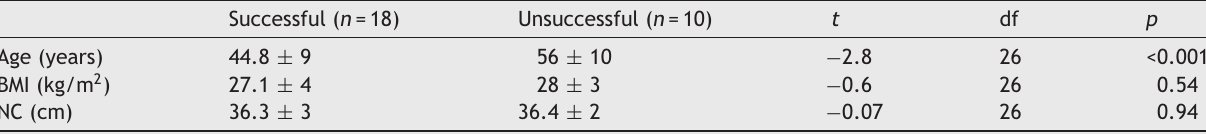
BMI, body mass index; NC, neck circumference. Statistically significant p -value <0.05 (Student’s t -test for independent samples).